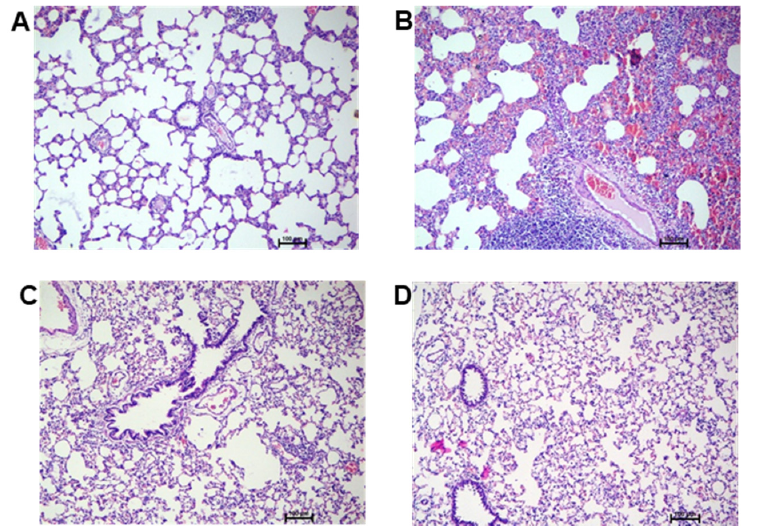
Figure 6. Haematoxylin and eosin (H,E)-stained representative rat lung tissue histopathology im- ages of ( A ) normal control, ( B ) diseased control, ( C ) standard treatment with conventional dexamethasone injection, and ( D ) developed test formulation treatment.